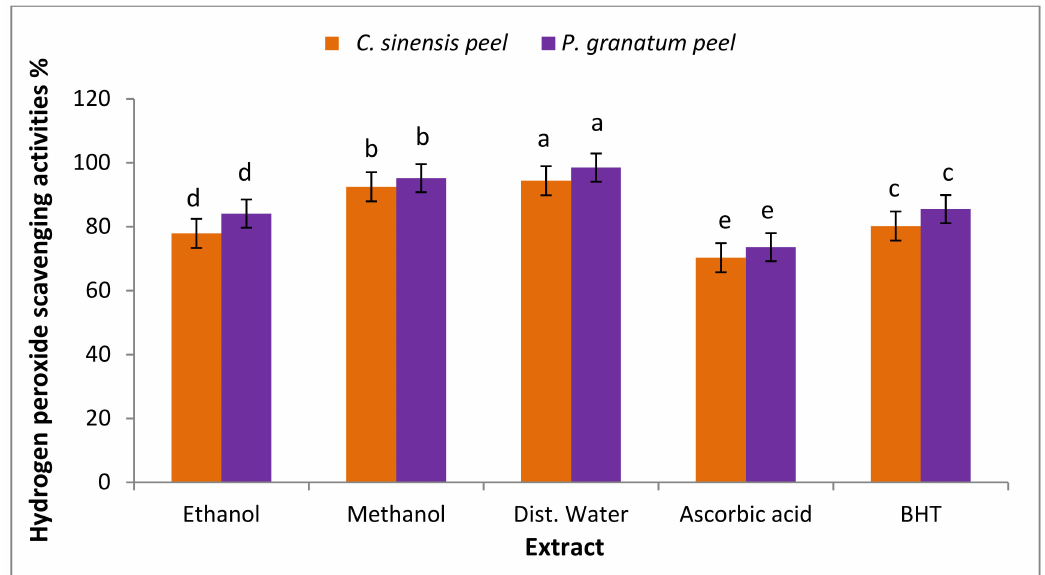
Figure 6. Hydrogen peroxide scavenging activity of C. sinensis and P. granatum peel extract. Each value is a mean ( ± SD) of three replicates. The different letters on the same bar show a significant difference according to Duncan’s test at p ≤ 0.05.